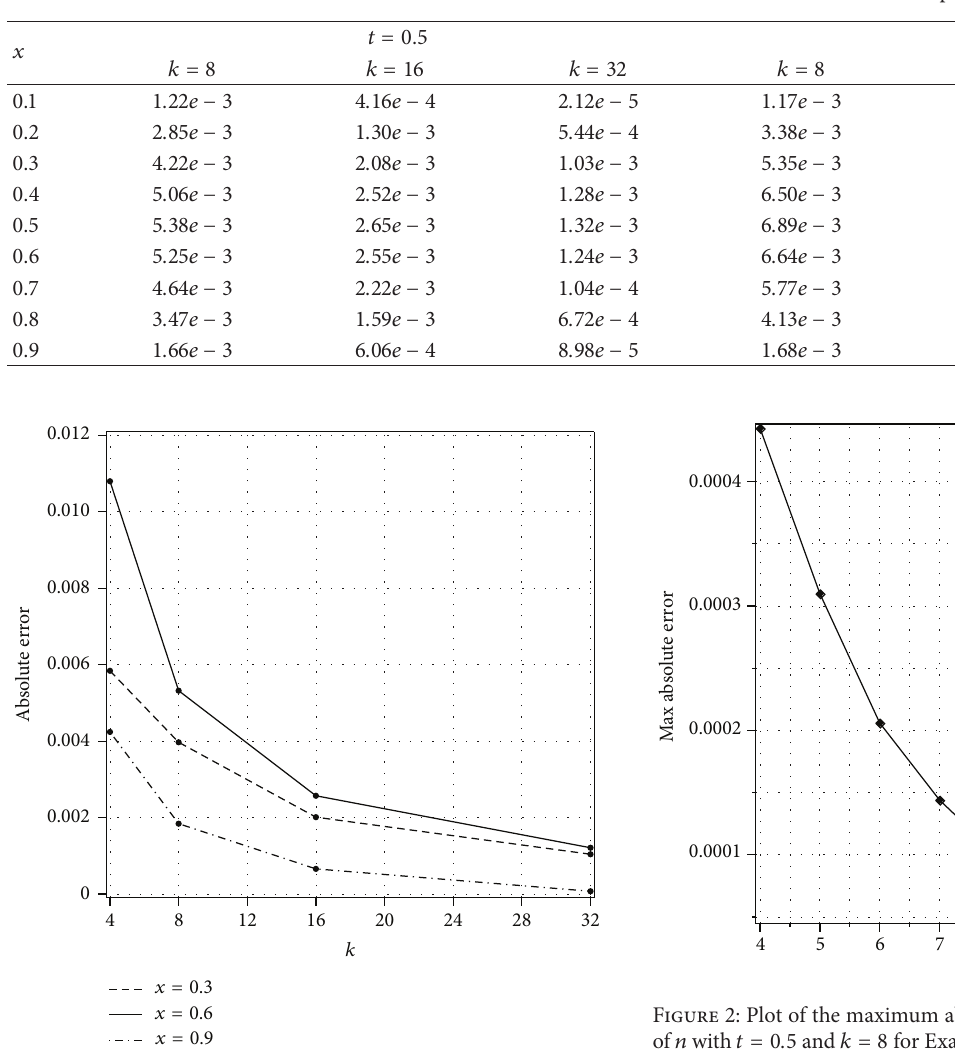
Figure 1: Plot of the absolute errors for different values of 𝑘 with 𝑡 = 0.5 and 𝑛 = 3 for Example 1.